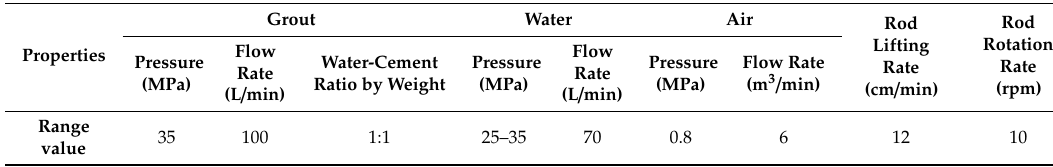
Table 3. Construction parameters of jet grouting